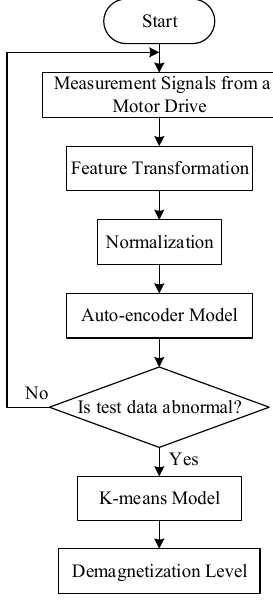
Figure 1. Flowchart of demagnetization fault diagnosis.